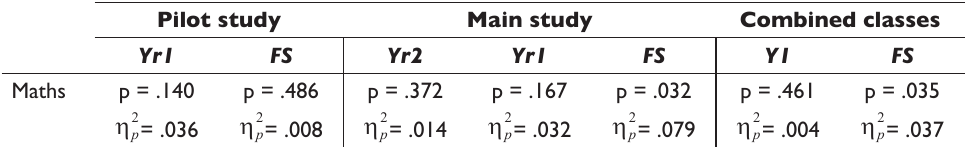
Table 3: Assessments in mathematics in which the change in scores over time for the intervention groups was statistically significantly greater than for the controls Pilot study Main